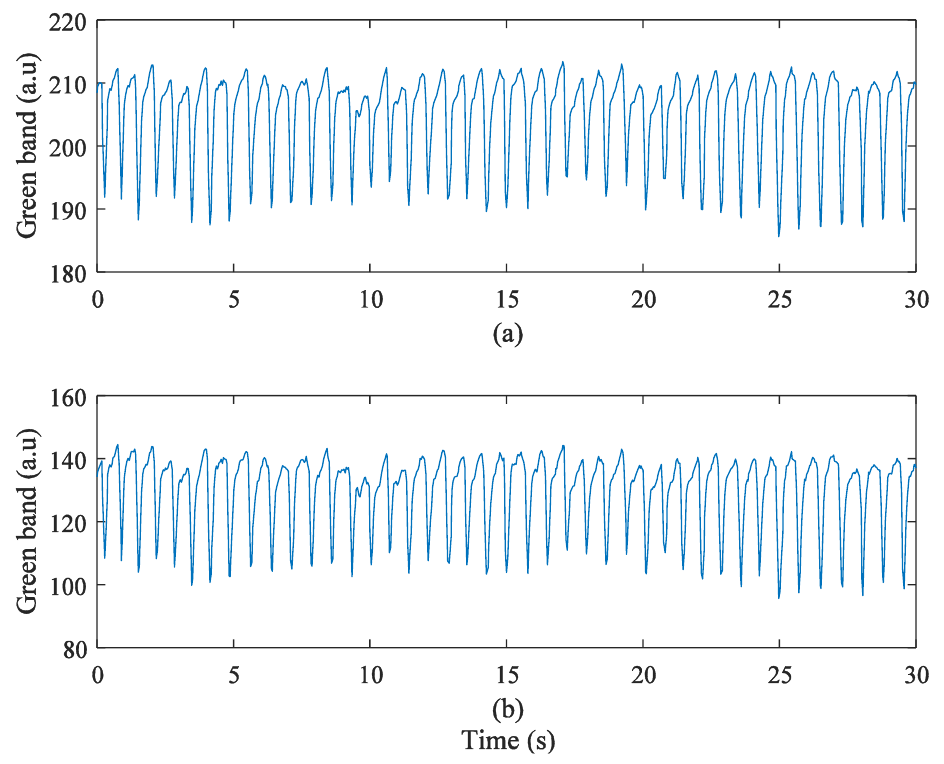
Figure 16. Galaxy S6 with LED On: ( a ) all regions; ( b ) selected dominant region.